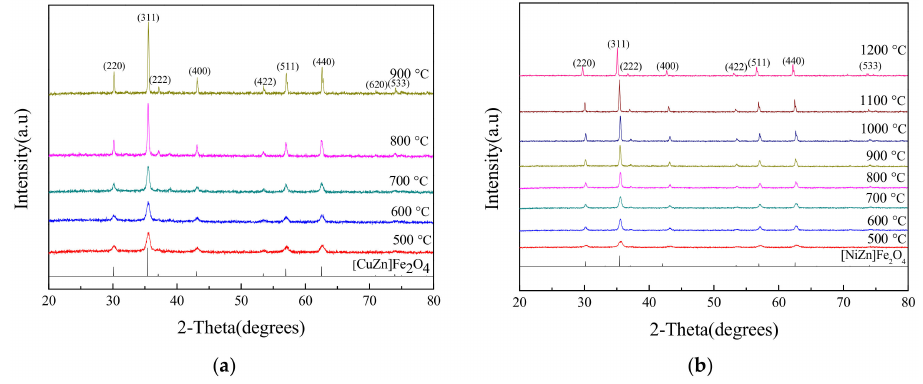
Figure 4. The effect of sintering temperature on the XRD pattern. ( a ) Cu 0.7 Zn 0.3 Fe 2 O 4 ; ( b ) Ni 0.5 Zn 0.5 Fe 2 O 4